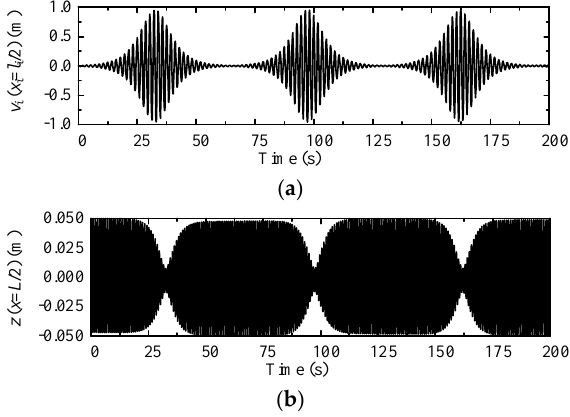
Figure 4. Undamped parametric resonance of the SFT tube-cable system: ( a ) displacement in the mid-section of cable; ( b ) displacement in the mid-span of tube.